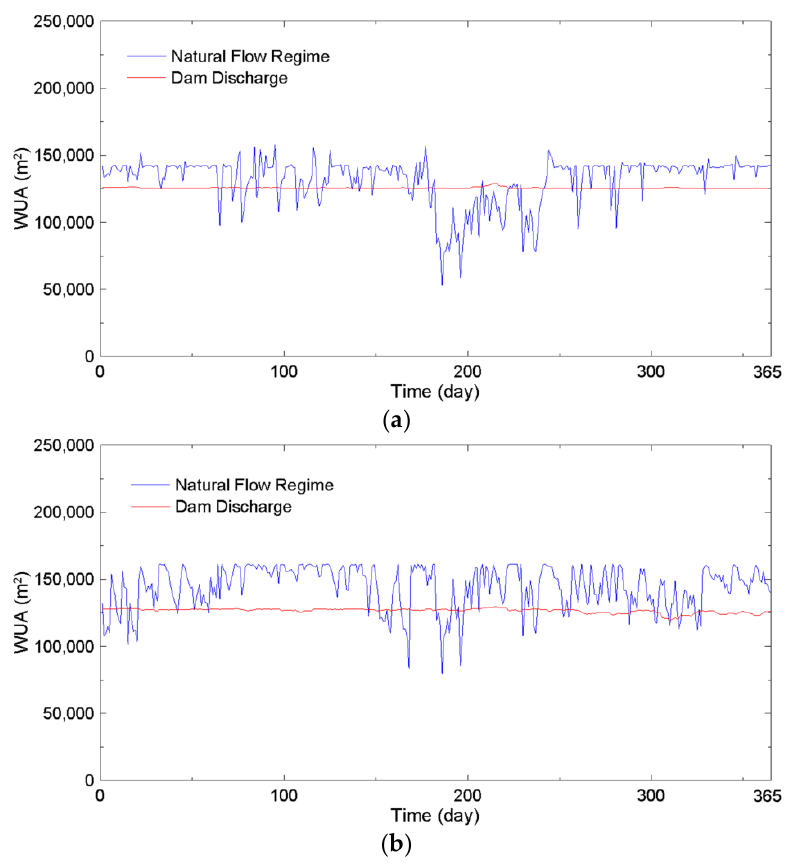
Figure 7. The change of weighted usable area (WUA) with time: ( a ) Zacco platypus and ( b ) Baetis fuscatus .